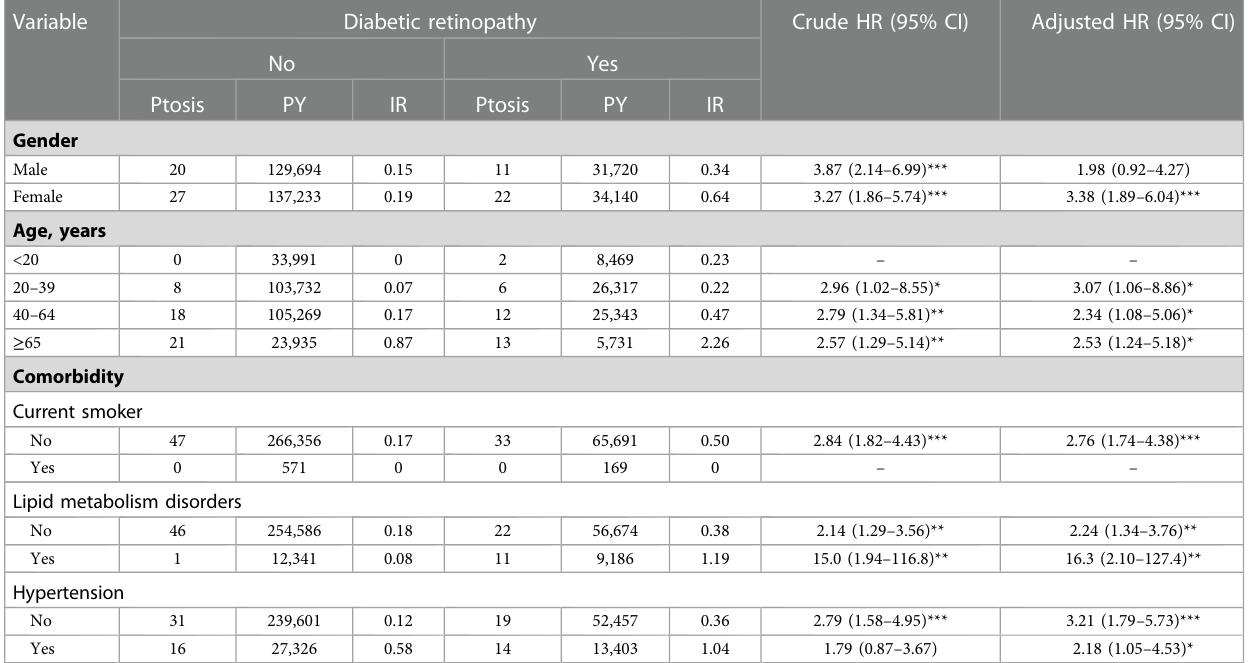
TABLE 3 Incidence rate and hazard ratio of ptosis between with and without diabetic retinopathy strati fi ed by gender, age and comorbidities. Variable Diabetic